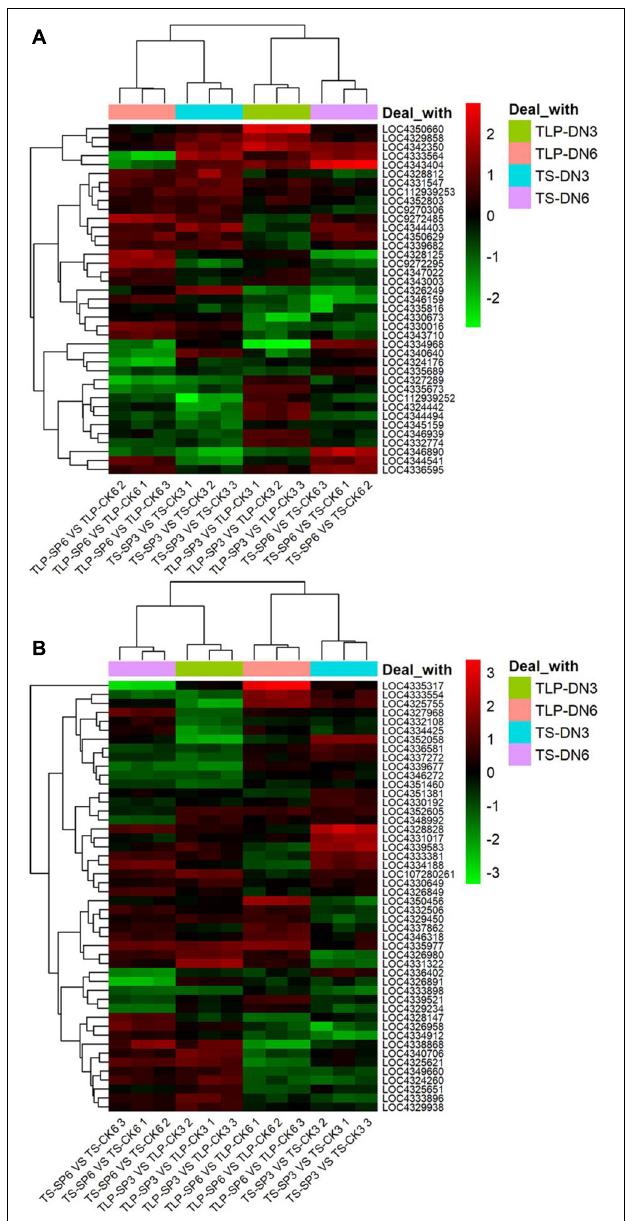
FIGURE 12 | The relative expression levels of TCA cycle and amino acid metabolism genes in two different rice varieties. The heat map shows the expression fold change in rice leaves obtained by qRT-PCR. The relative expression is calculated by the gene expression of the space group and the control group at different growth periods. (A) The expression of genes related to the TCA cycle. (B) Expression of genes related to amino acid metabolism. Red indicates that the gene expression is up-regulated, and green metabolism is down-regulated. The normalization of gene expression was obtained by log2 transformation. Hierarchical clustering analysis was performed using